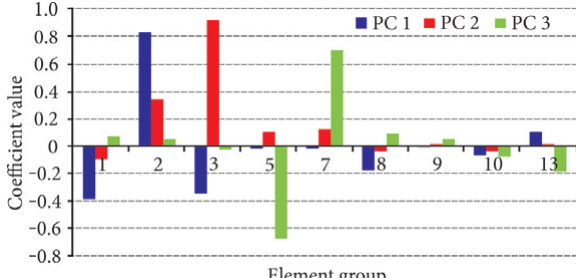
Fig. 4. Principal Component coefficients of first inspections of slab bridge typology